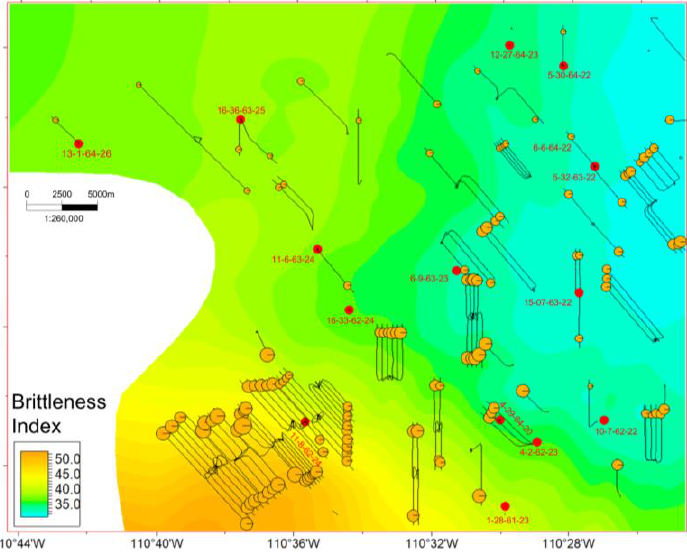
Figure 13. Map view of the brittleness index in the examined region. The grey circle represents the one-year gas production equivalence per stage for horizontal wells, scaled by production values.